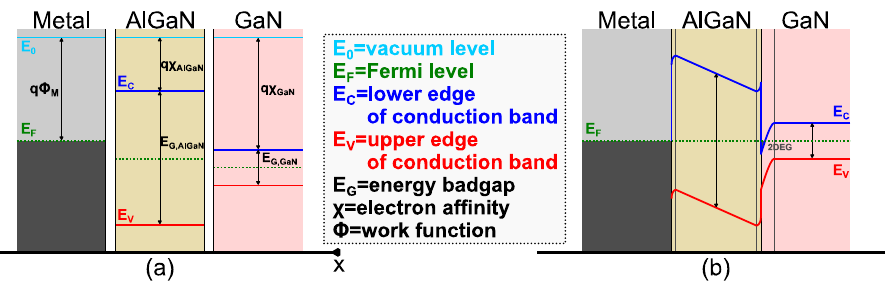
Figure 1. Ideal representation of a monodimensional band diagram of a metal/AlGaN/GaN hetero- structure (not to scale) when ( a ) the three materials are isolated from each other and ( b ) when the materials are in contact at thermodynamic equilibrium. The correct band bending depends on the exact charge spatial distribution.